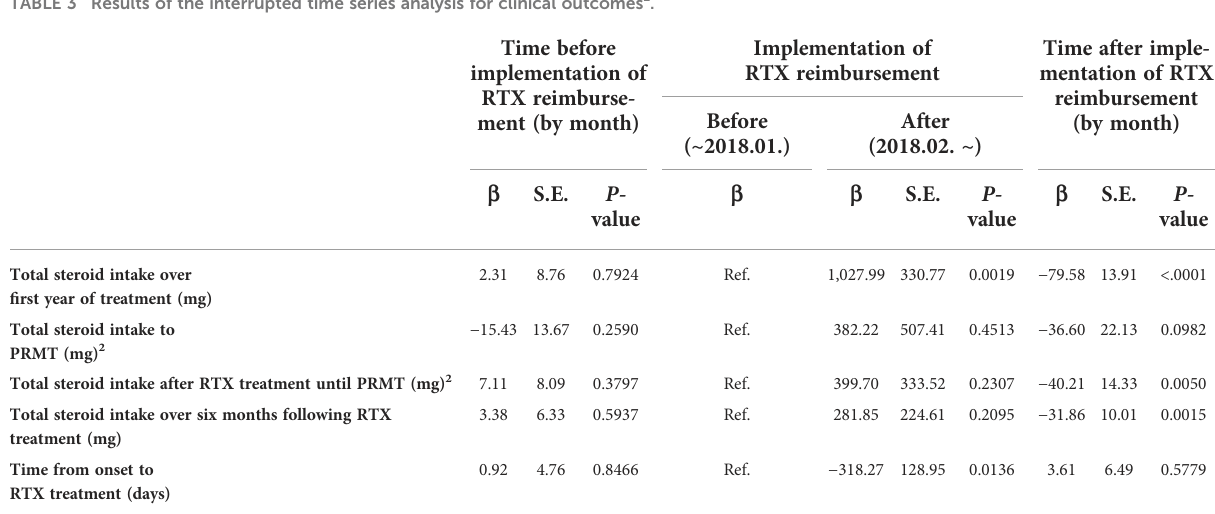
TABLE 3 Results of the interrupted time series analysis for clinical outcomes 1